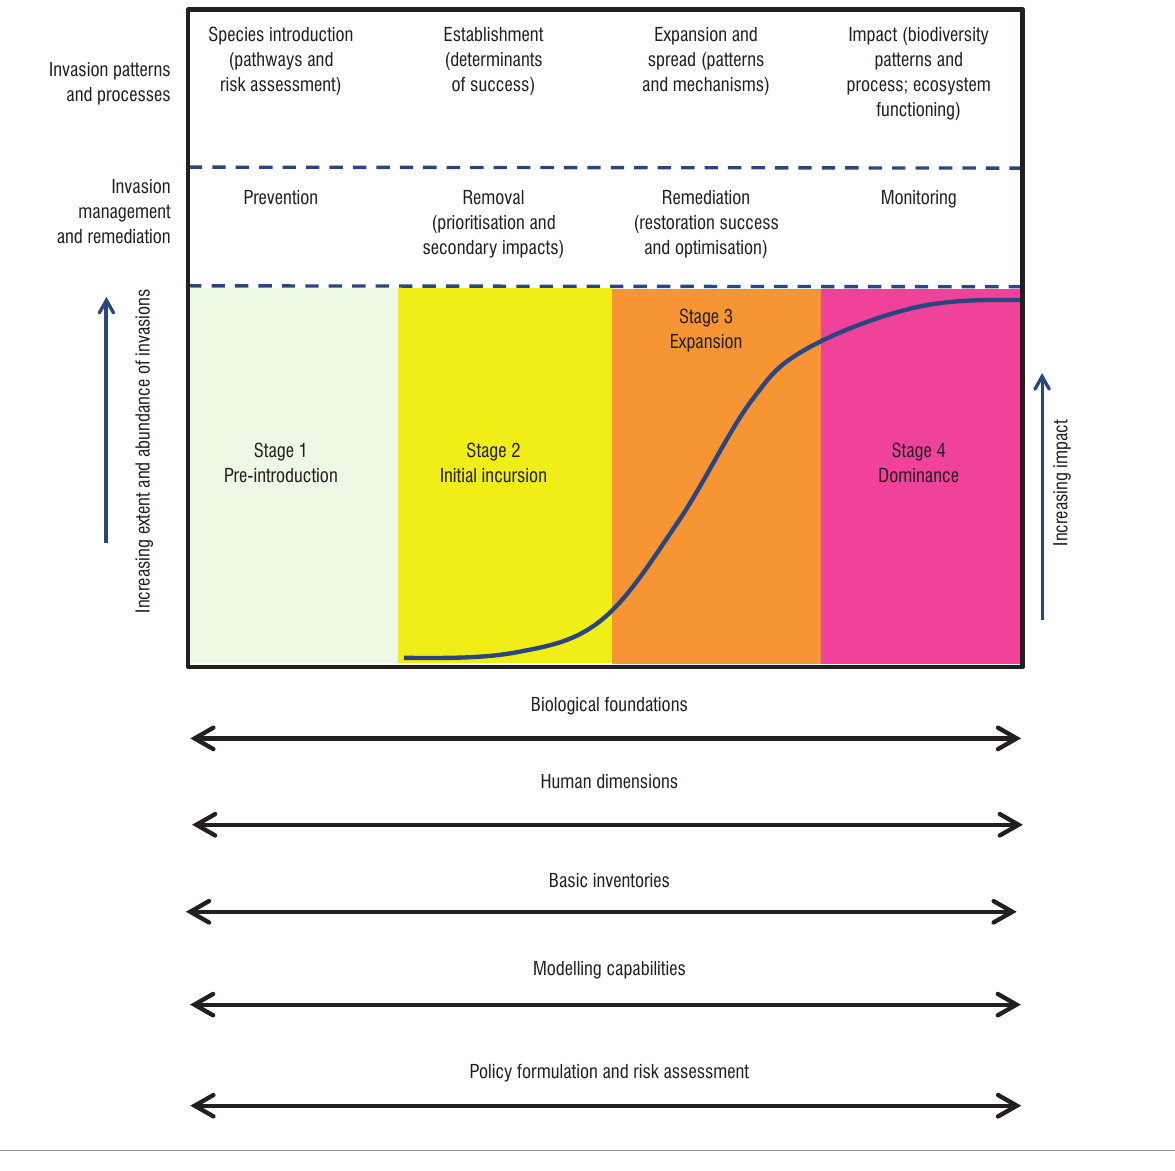
A framework used by the Centre for Invasion Biology to guide relevant and comprehensive research on biological invasions. There are four stages of invasion, dependent on the extent and abundance of the species concerned: pre-introduction, initial incursion, expansion, and dominance. At each stage, it is necessary to consider the patterns and processes that drive invasions, as well the management and remediation responses required to reduce the spread and impacts of invasive alien species. Cross-cutting issues that apply to all stages of invasion are indicated by the arrows below the